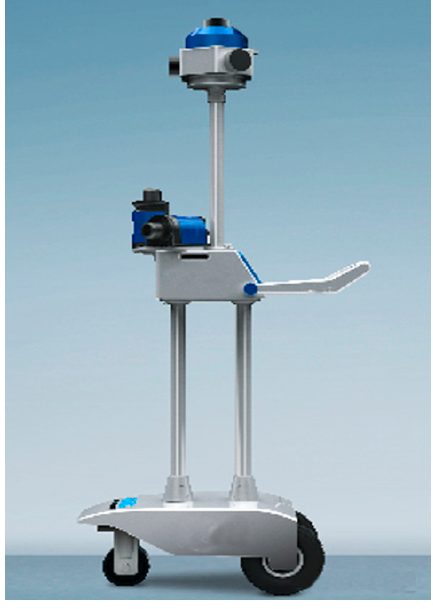
Figure 6. Our SLAM system. It consists of three laser scanners, a panoramic camera, and two odometers.